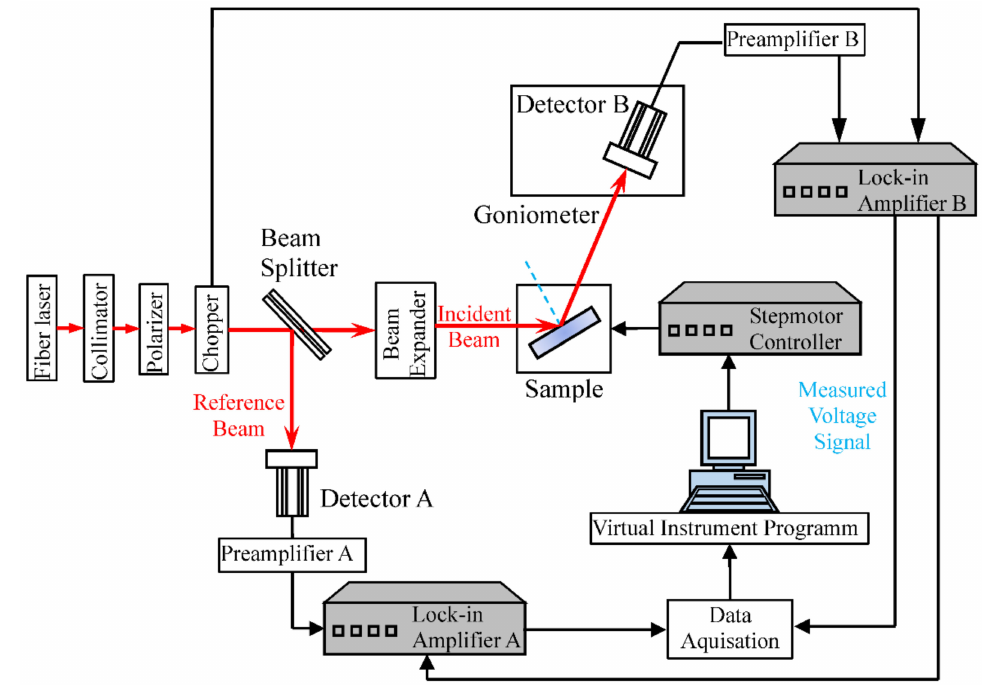
Figure 3. Schematic diagram of the BRDF measurement system